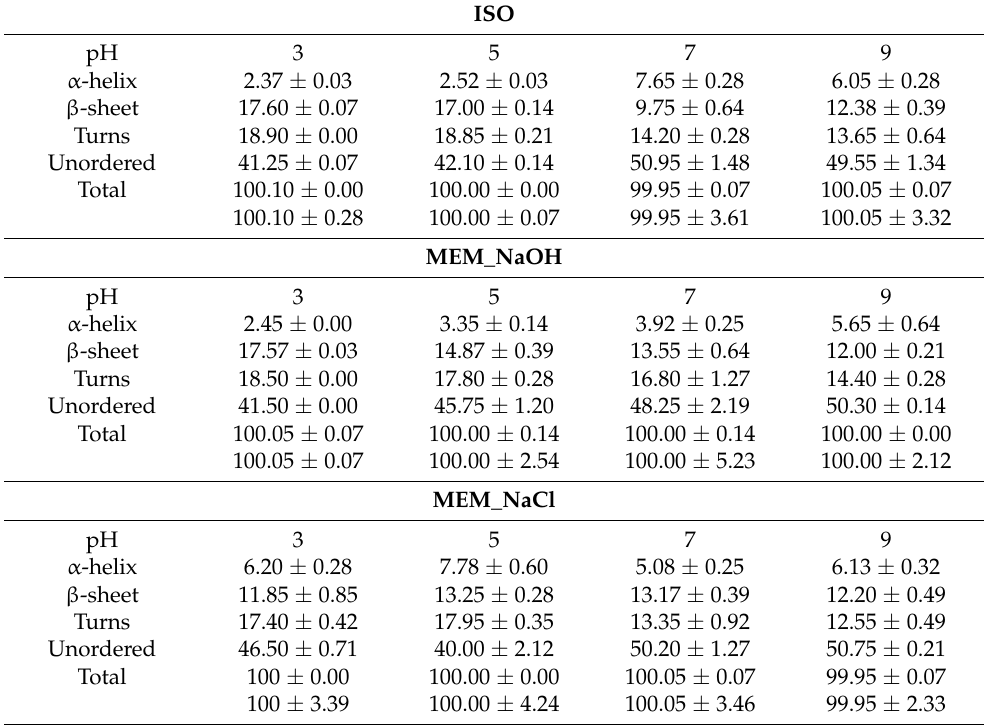
Figure 1. SDS-PAGE of isoelectric pH precipitated isolate (ISO, lanes 4 and 7), and membrane isolates using alkaline (MEM_NaOH, lanes 3 and 6) and salt (MEM_NaCl, lanes 2 and 5) solution extracts under reducing ( A ) and non-reducing ( B ) conditions. Lanes 1 and 8 = standard proteins. Table 3. Secondary structure fractions at different pH values of isoelectric pH precipitated isolate (ISO), and membrane isolated proteins from alkaline (MEM_NaOH) and salt (MEM_NaCl) solution